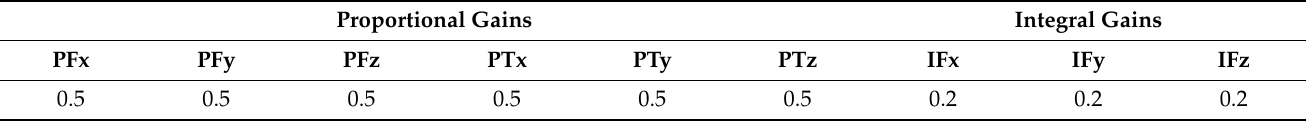
Table 2. Proportional and integral gains for the PI controller (Figure 3).